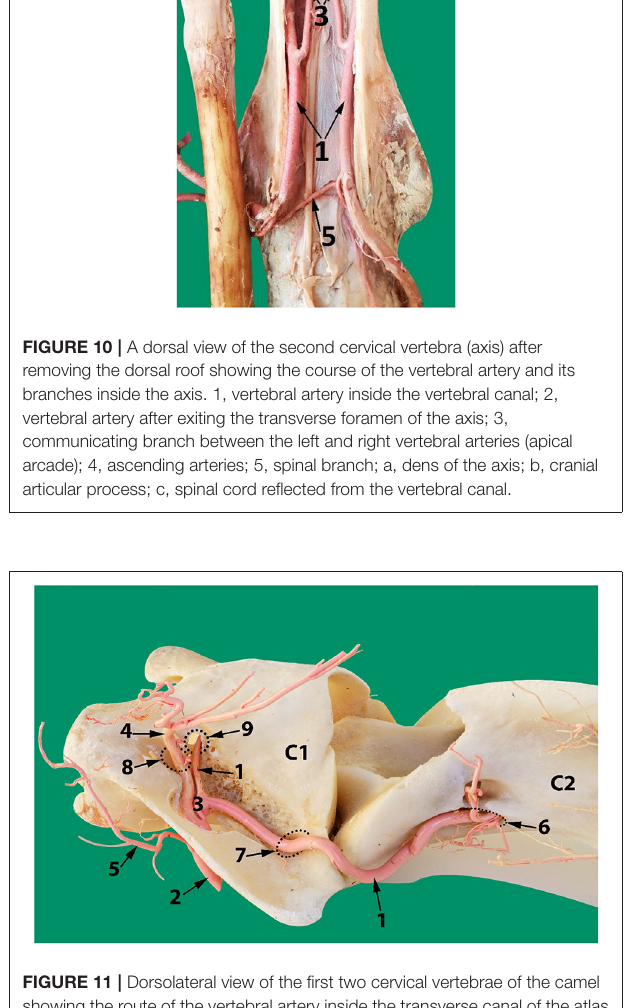
FIGURE 11 | Dorsolateral view of the first two cervical vertebrae of the camel showing the route of the vertebral artery inside the transverse canal of the atlas and its anastomosis with the occipital artery inside the alar foramen. 1, vertebral artery; 2, occipital artery; 3, anastomosis between the vertebral artery and the occipital artery; 4, dorsal muscular branch; 5, ventral muscular branch; 6, ventral opening of the transverse foramen of the axis; 7, transverse foramen of the atlas; 8, dorsal opening of the alar foramen; 9, lateral vertebral